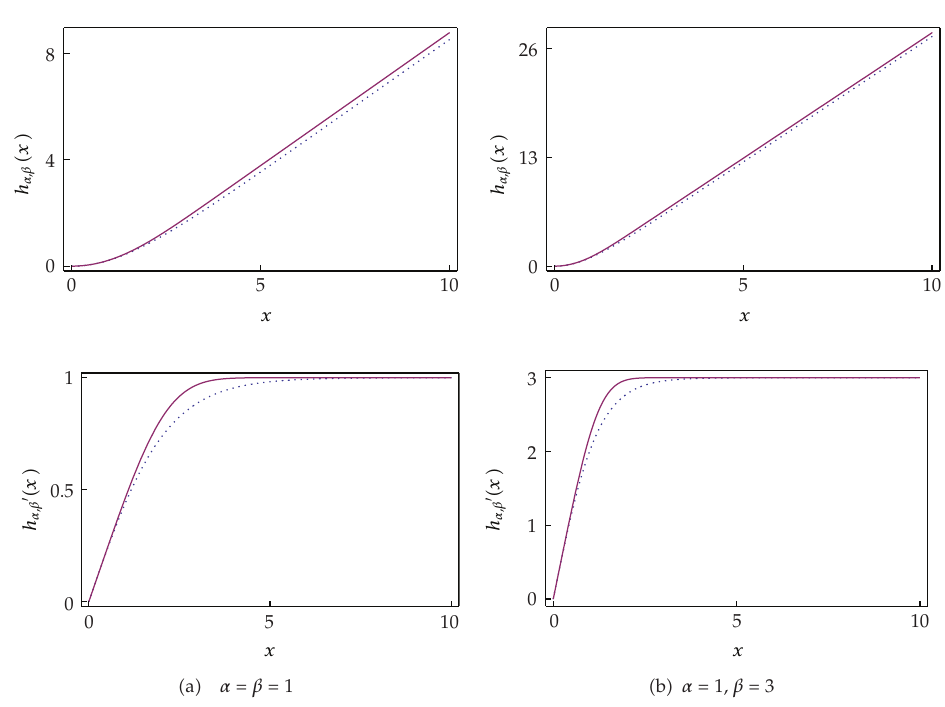
Figure 1: Graphs of the presented solution h α,β (cid:3) x (cid:4) and its derivative (cid:3) dotted lines (cid:4) compared with those of the numerical solution f α,β (cid:3) x (cid:4) (cid:3) solid lines (cid:4)